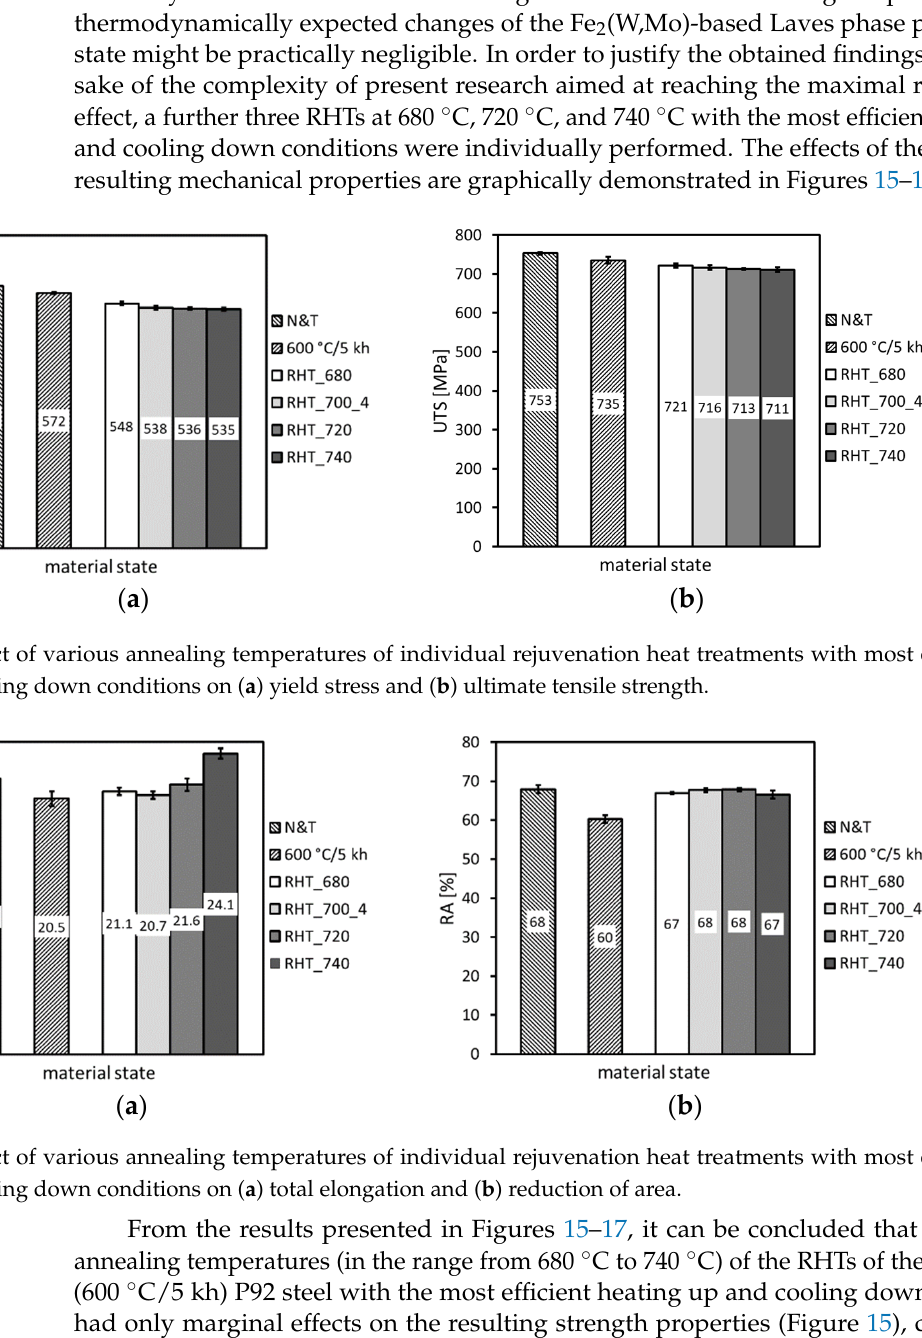
Figure 17. The effect of various annealing temperatures of individual rejuvenation heat treatments with most efficient heating up and cooling down conditions on ( a ) hardness and ( b ) impact toughness.